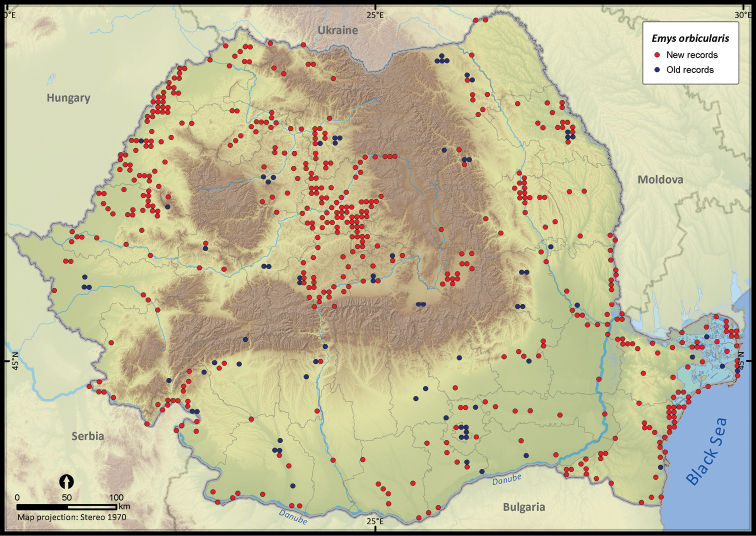
Emys orbicularis.